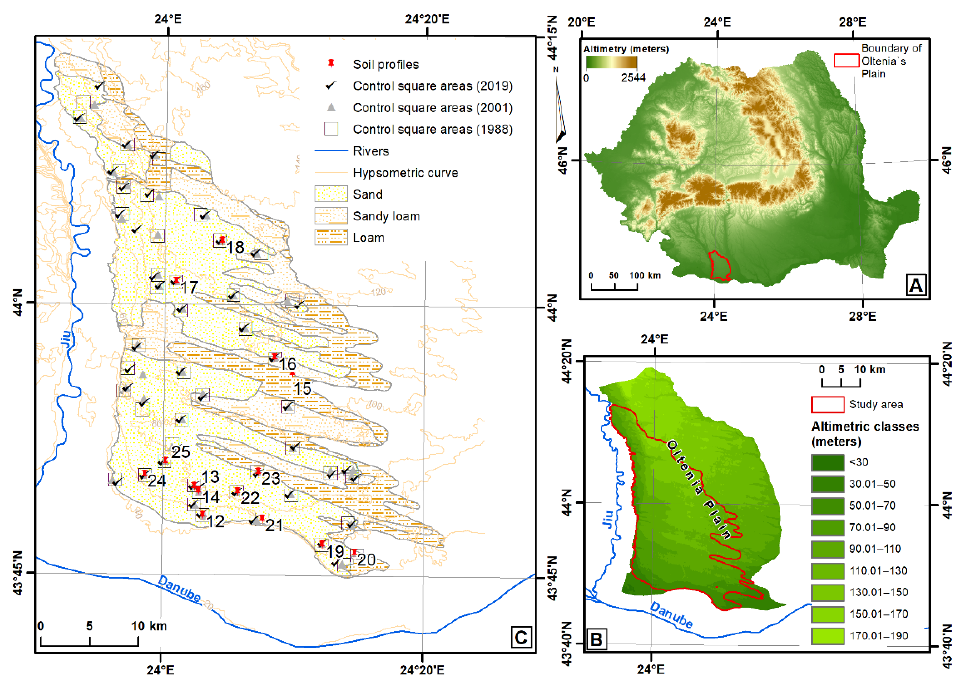
Figure 1. Soil texture and location of soil profiles and control square areas (( A )—the geographical location of the Oltenia’s Plain within Romania, ( B )—the geographical location of the study area within the Oltenia’s Plain, ( C )—the numbers represent soil profiles extracted from scientific literature).